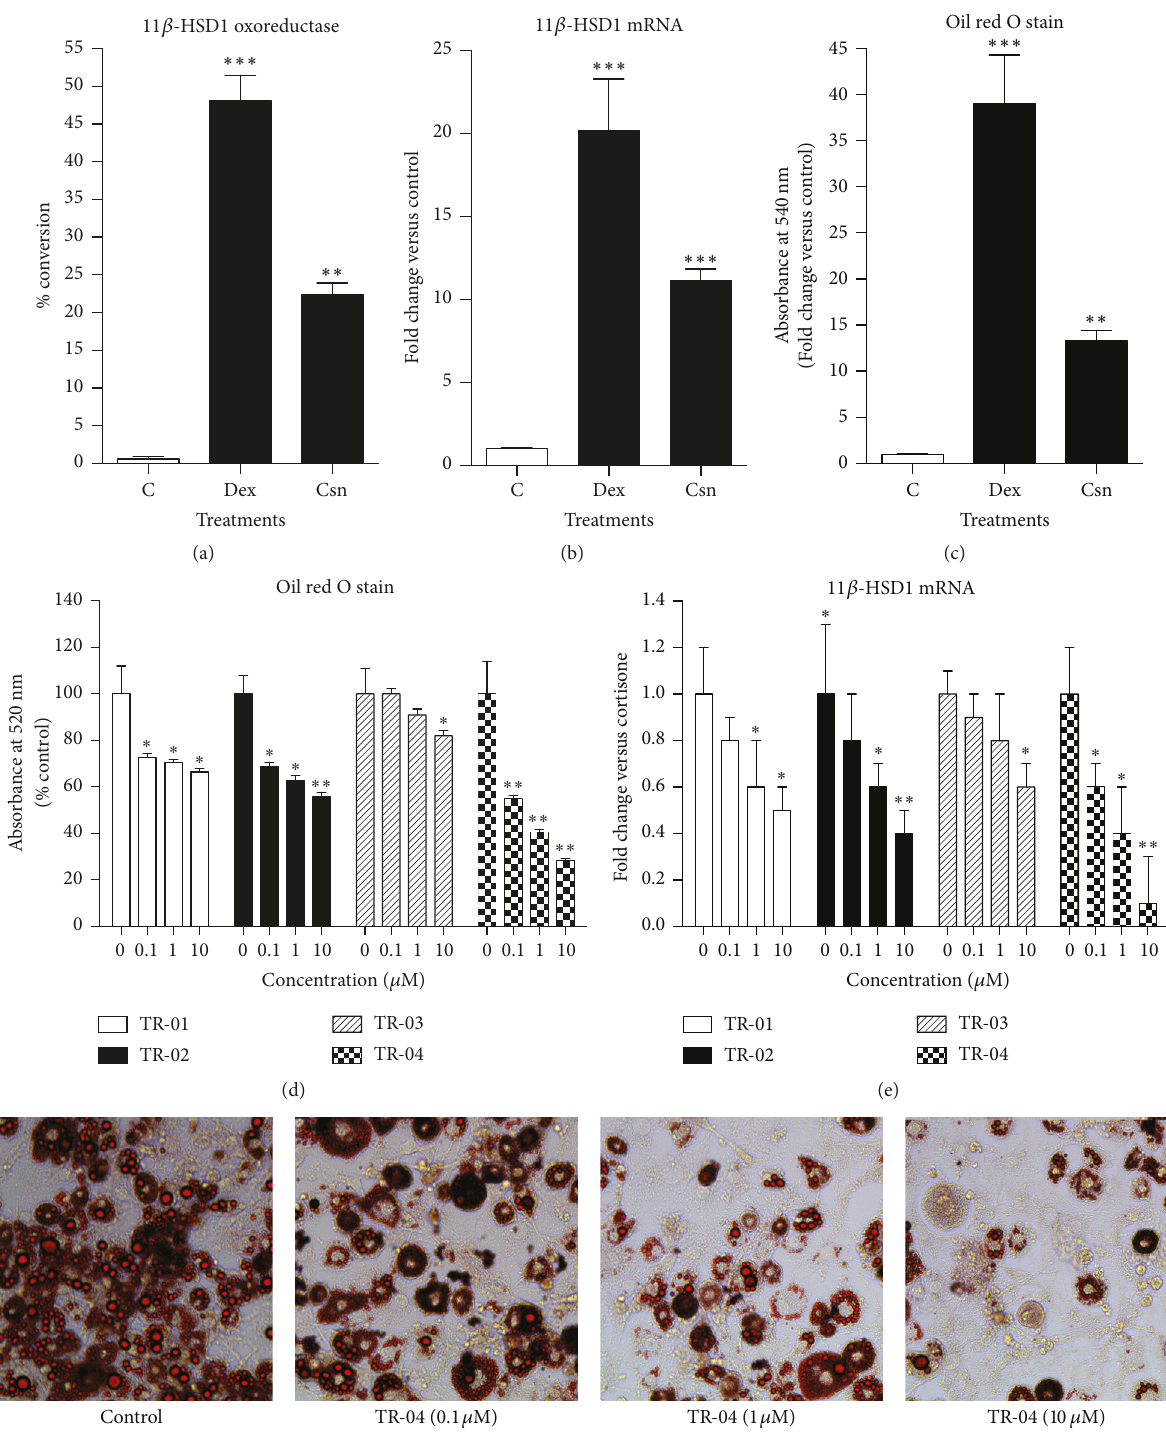
Figure 5: Tetrahydrothiazolopyridine derivatives TR-01–4 reduced adipogenesis in the 3T3-L1 adipocytes in a dose-dependent manner. Adipocytedifferentiationinthepresenceof1 𝜇 Mcortisone(Csn)washalflessefficientthanstandard0.25 𝜇 Mdexamethasone(Dex)induction as evident from induction of the (a) 11 𝛽 -HSD1 activity, (b) 11 𝛽 -HSD1 expression, or (c) lipid accumulation. Dosing of cortisone-treated adipocytes with 0–10 𝜇 M of TR-01–4 further decreased (d) lipid accumulation as quantified with Oil red O staining and (e) 11 𝛽 -HSD1 mRNA levels as measured by qPCR. (f) Oil red O staining of adipocytes differentiated with different concentrations of TR-04 for 8 days. Data are the mean ± SEM ( 𝑛 = 3 ), ∗ 𝑝 < 0.05 , ∗∗ 𝑝 < 0.01 , and ∗∗∗ 𝑝 < 0.001 versus vehicle control by Dunnett’s test subsequent to one-way